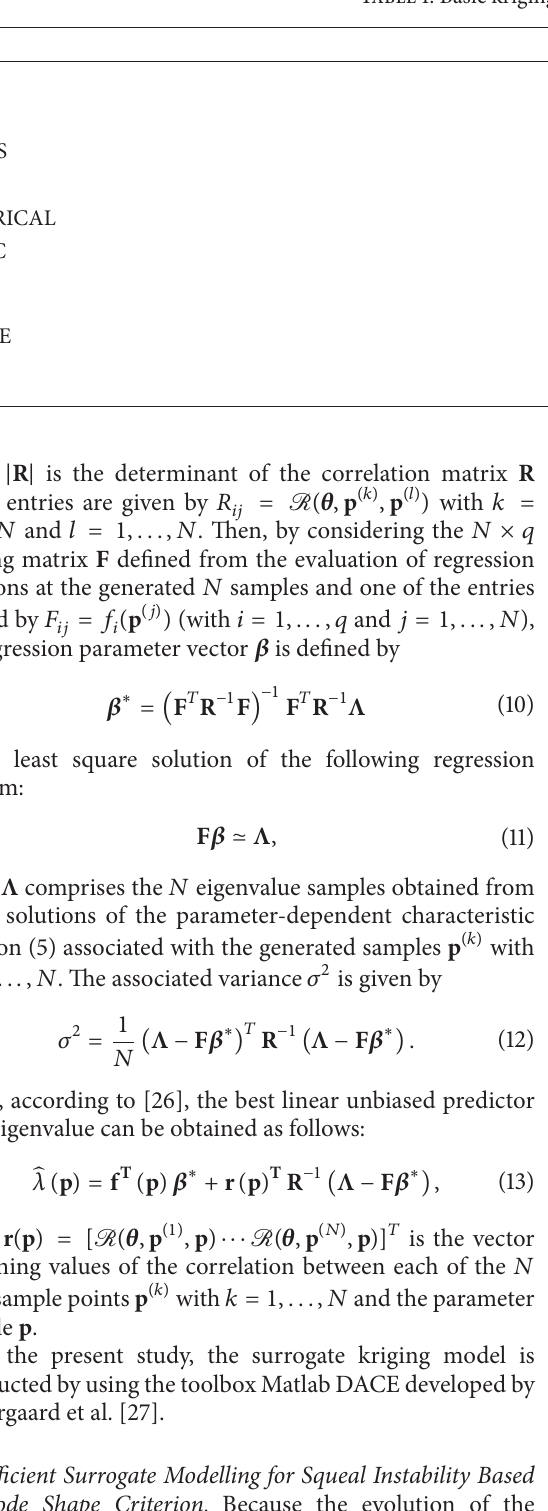
Table 1: Basic kriging correlation